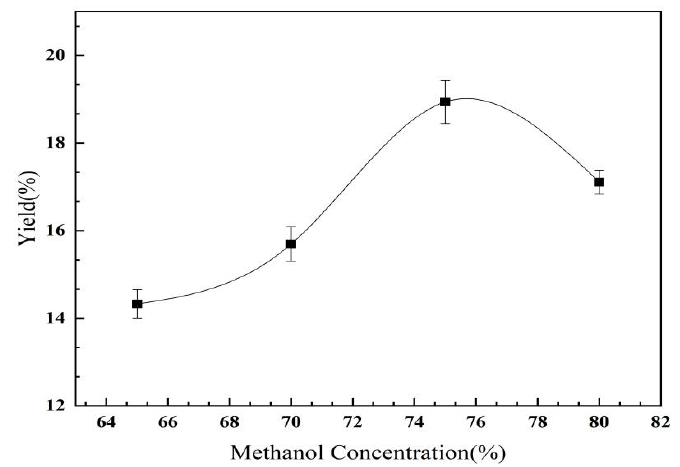
Figure 6. Influence of methanol concentration on the yield of C. oleifera saponins (liquid–solid ratio = 3.5:1; extraction temperature = 65 °C; extraction time = 180 min).